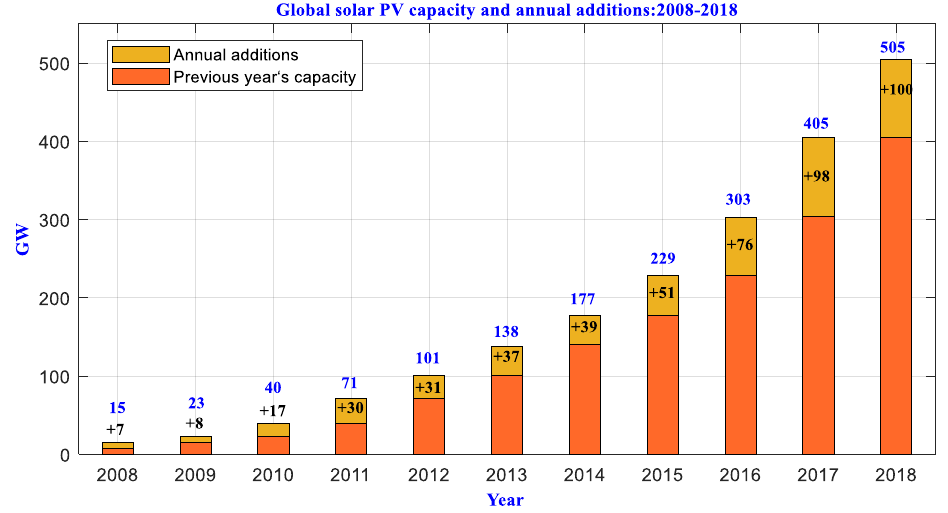
Figure 1. Photovoltaic (PV) capacity and annual addition in the last ten year.